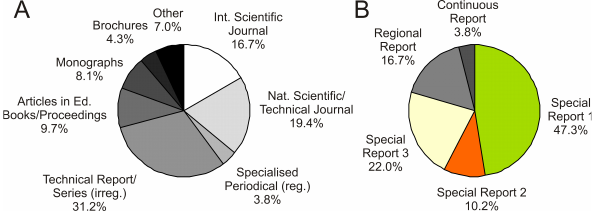
Fig. 3. Typology of all documents by (A) reference class and (B) with respect to event